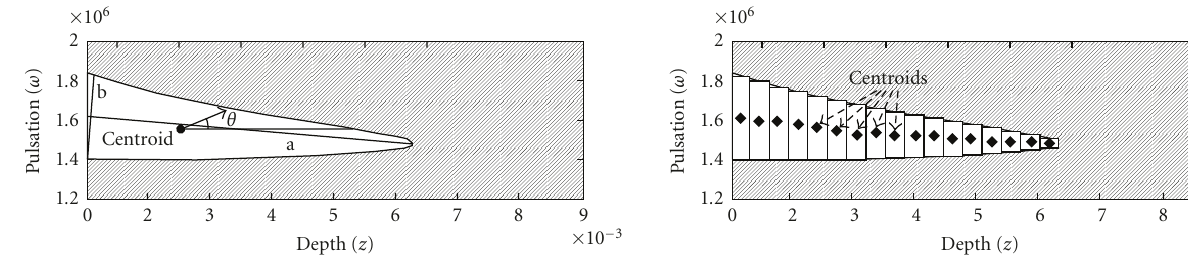
Figure 3: Description of BS and eccentricity parameters. Figure 4: Centroid estimation using decomposition of the bina- rized TFR into small